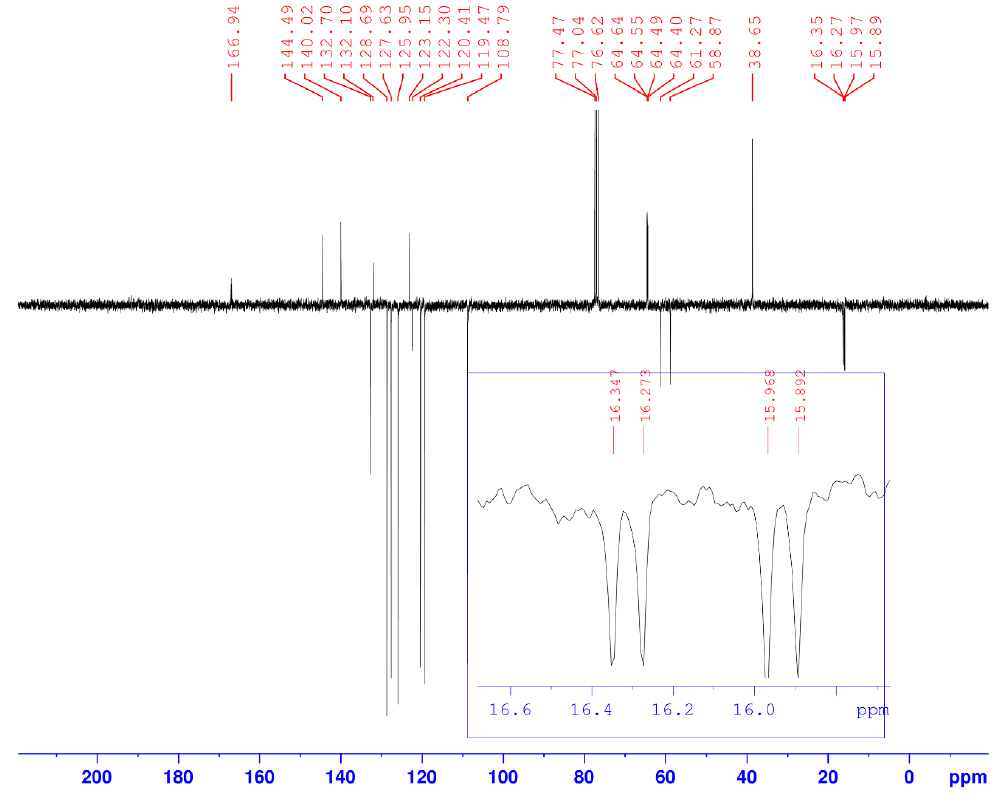
Figure 2. 13 C-NMR spectrum of compound ( 3 ).